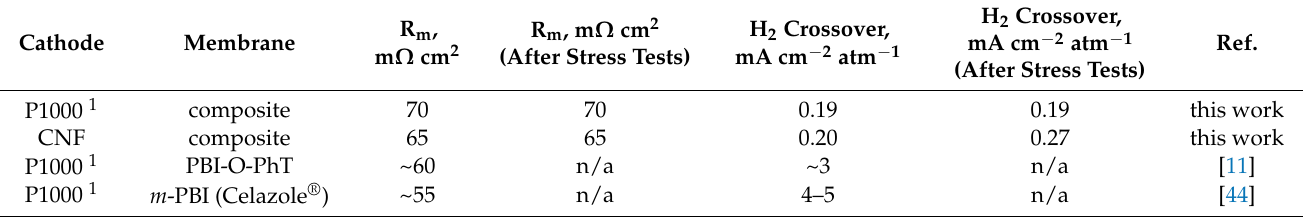
Table 2. The membrane resistance (R m ) data (180 °C, 0.4 A cm − 2 ) and H 2 crossover through the membrane (180 °C) in HT-PEM fuel cell operation conditions for MEAs with Celtec®P1000 anodes and different cathodes and membranes.